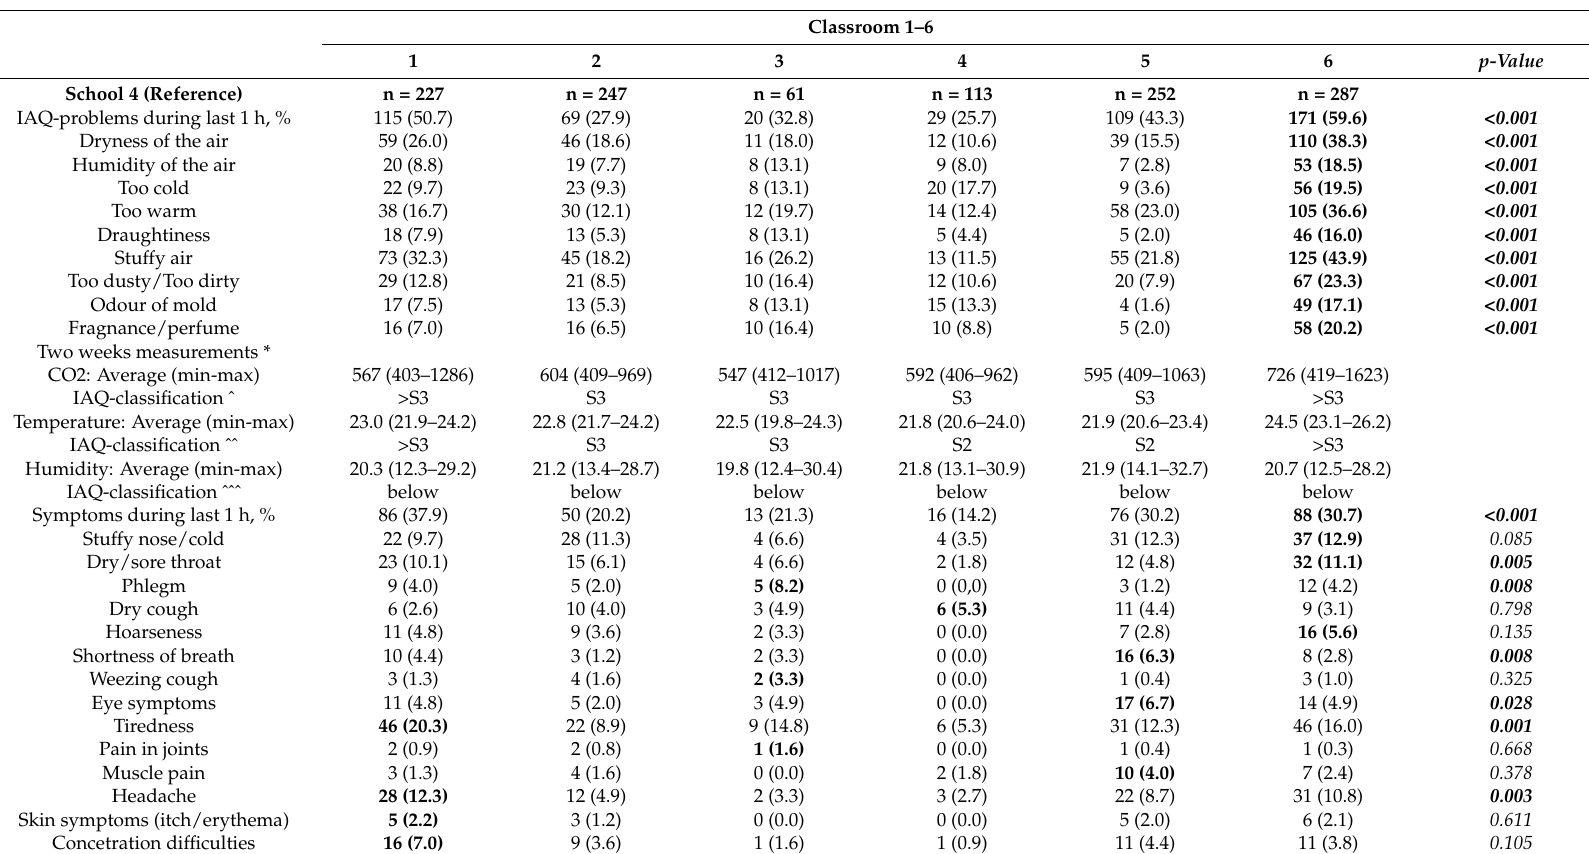
Table 7. Differences between the classrooms in the IAQ problems and symptoms during the last hour among pupils and results of CO 2 , temperature, and relative humidity measurements in school